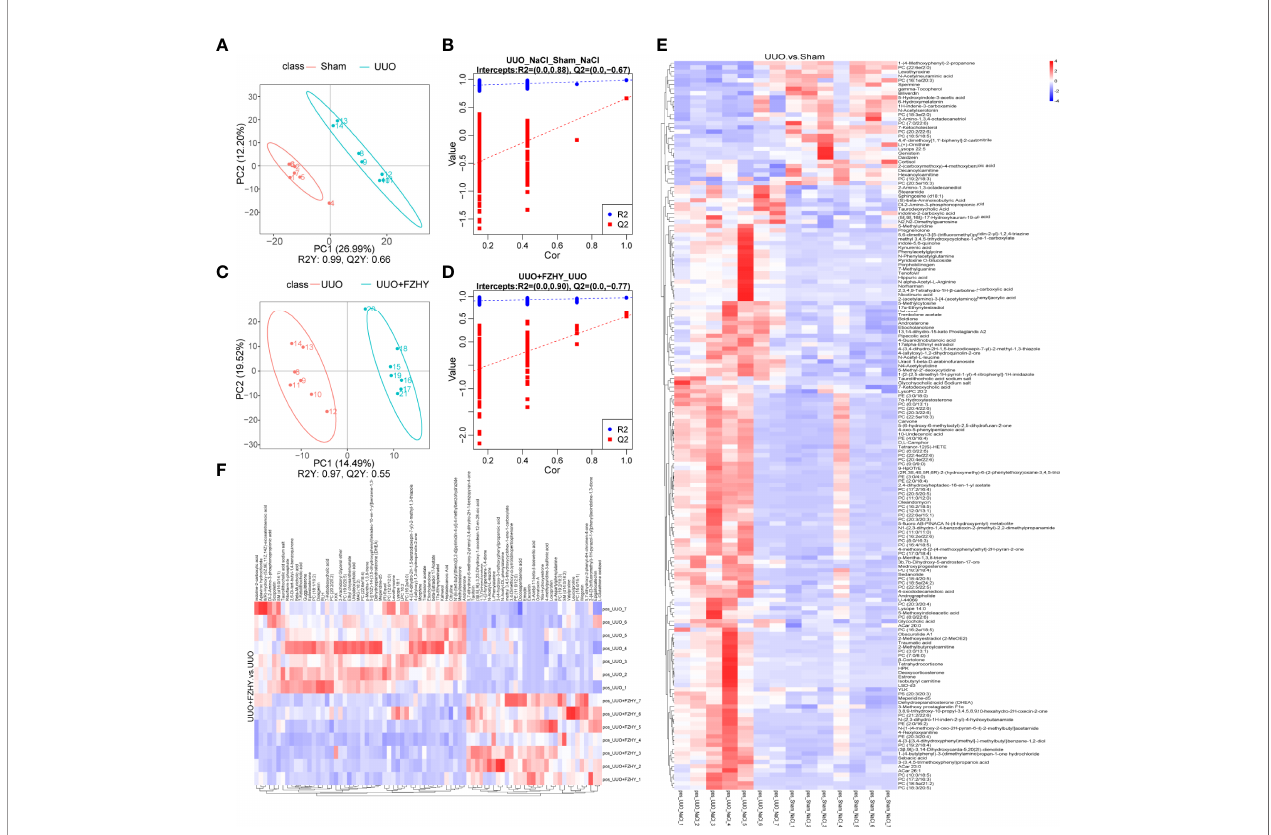
FIGURE 5 | Metabolomics analysis of anionic metabolites. PLS-DA score plots for the comparison of the global metabolite pro fi les in the UUO and sham groups (A) and the UUO+FZHY and UUO groups (C) . Validation plot by permutation test for the UUO and sham groups (B) and the UUO+FZHY and UUO groups (D) . The heatmap plot for metabolites between the UUO vs. sham groups (E) and the UUO+FZHY vs. UUO groups (F)